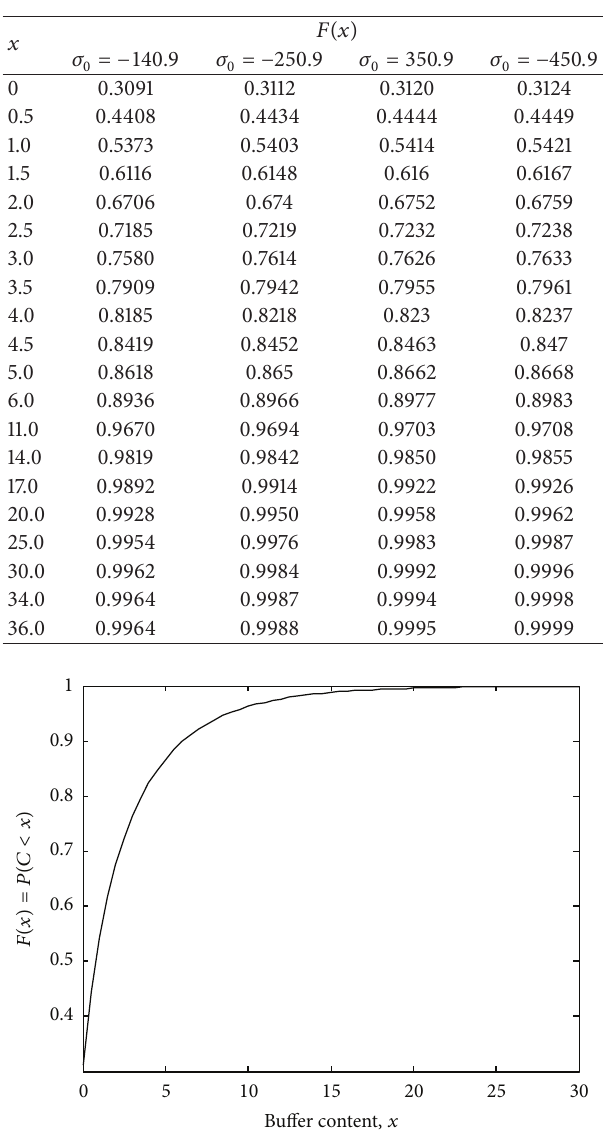
Figure 3: Variations of buffer content distribution against 𝑥